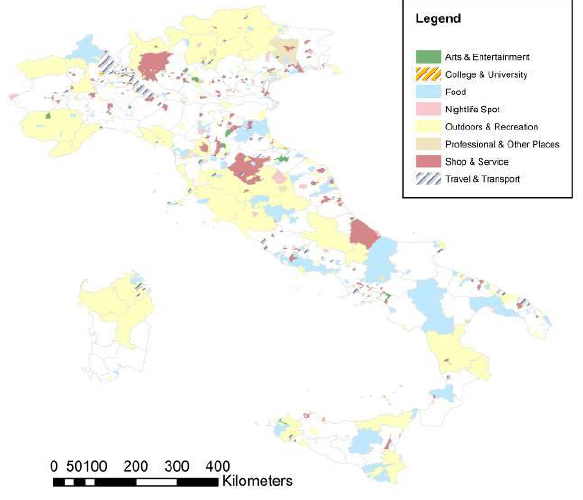
Figure 7. Discovering regions of different functions in Italy. A number of mined rules indicating the correlation between some commutes and sub-categories are presented in Table 4.